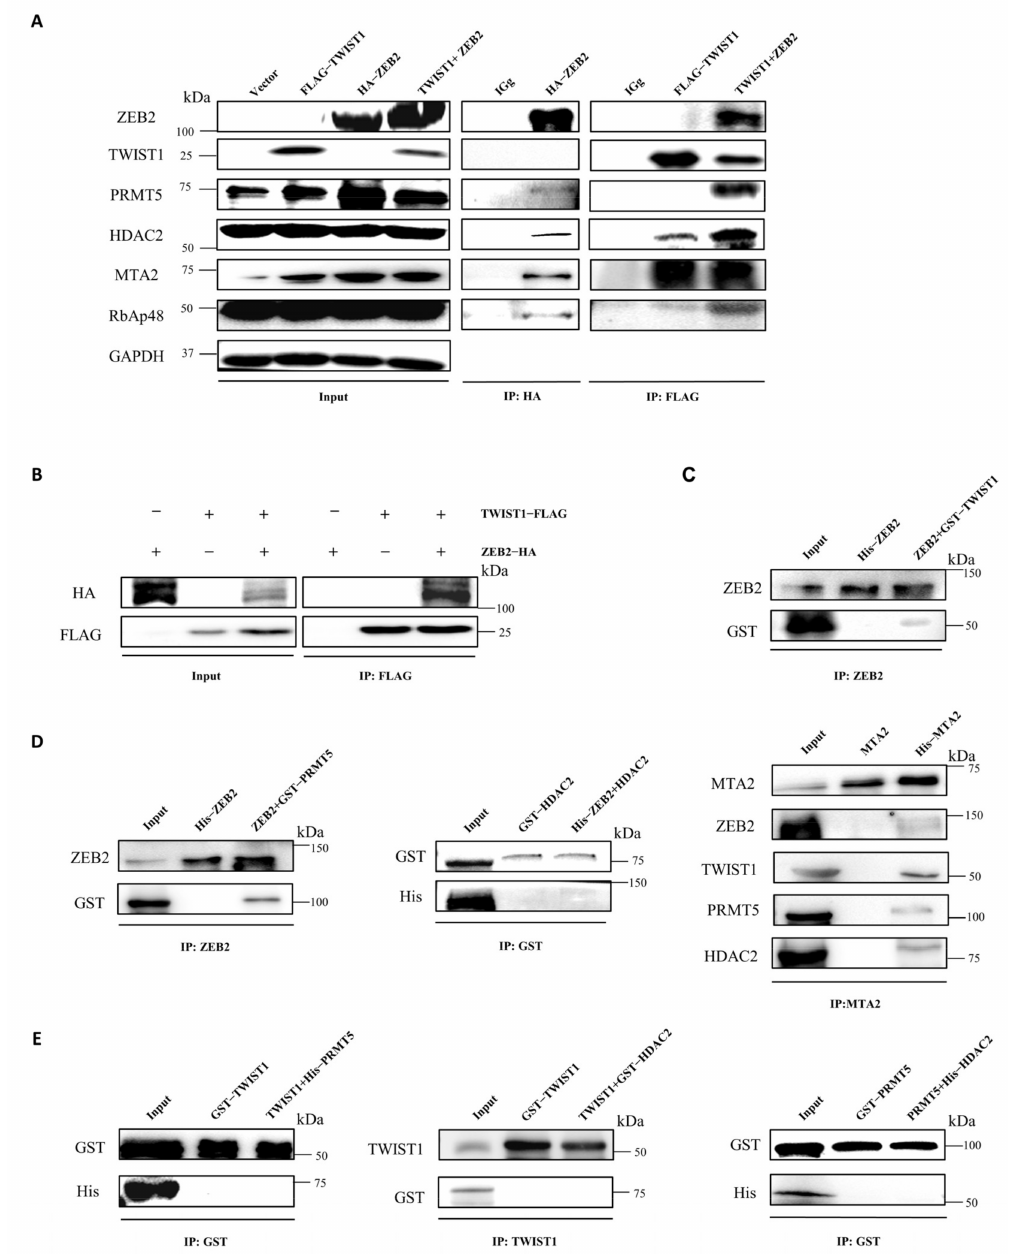
Figure 4. ZEB2 interacts with TWIST1, PRMT5, and NuRD complex to form a functional multicom- plex. Purification of ZEB2-containing protein complexes in SW480 cells. Cellular extracts from SW480 cells expressing HA (control) or HA-ZEB2 were immunopurified with anti-HA affinity beads. Eluates were analyzed by SDS-PAGE and mass spectrometry. The detailed data are provided in Table 1. ( A ) Association of ZEB2 with TWIST1, PRMT5, and NuRD. Whole-cell lysates from SW480 cells (TWIST1, ZEB2, and TWIST1+ZEB2) were immunoprecipitated with antibodies and the precipitated proteins were blotted with antibodies against the indicated proteins. IgG served as a negative control. ( B ) Co-immunoprecipitation of FLAG-tagged TWIST1 and HA-tagged ZEB2 transiently transfected in SW480 cells. Extracts were immunoprecipitated with FLAG antibody, and bound ZEB2 was detected by Western blotting. ( C – E ) GST pull-down assays were performed by mixing GST-fused proteins and 6*His-fused